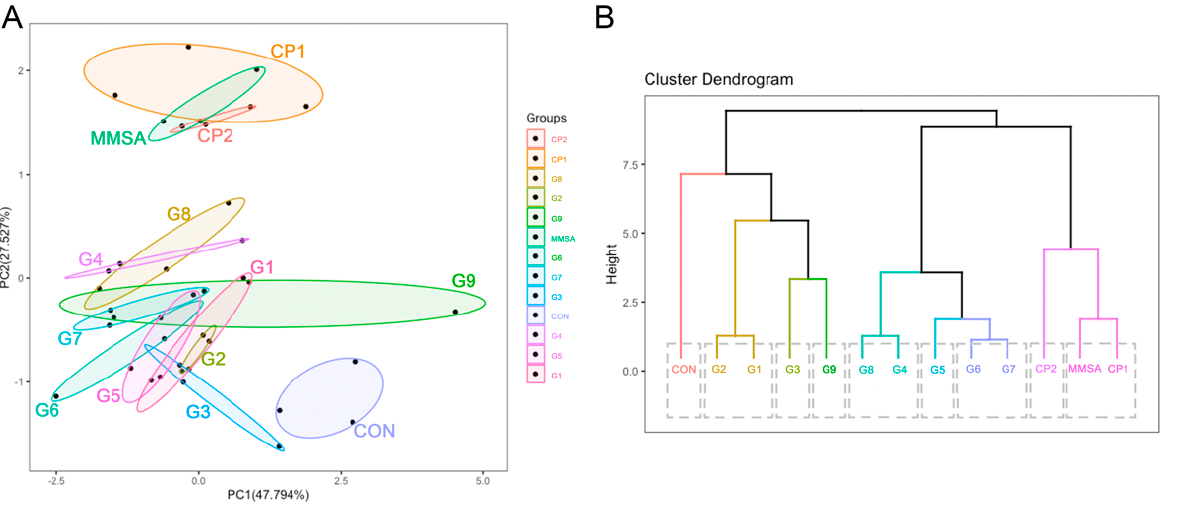
Figure 4. ( A ) Principal component analysis plot and ( B ) cluster analysis of mushroom-based meat sausage analogues comparing different formulations and commercial products.